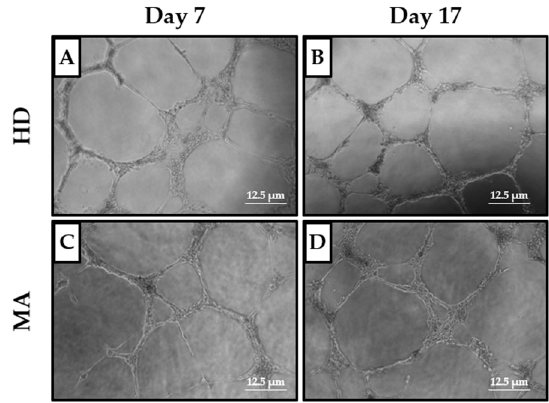
Figure 5. Tube formation assay on Human Umbilical Vein Endothelial Cell (HUVEC) cells in the presence of conditioned media from HD and MA EPC cultures at ( A , C ) day 7 and ( B , D ) day 17 (representative images are shown; 5× magnification, 12.5 µm scale bar): The angiogenic potential of the growth factors released by early and late EPCs was evaluated through the analysis of the photos from each condition by the Wimasis software. Three independent experiments for each condition have been considered.